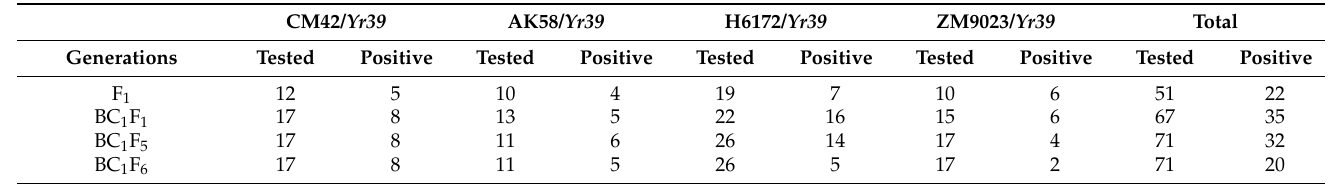
Table 2. Four cultivar (CM42, AK58, H6172 and ZM9023) crosses with Yr39 showed positive lines in different generations as detected by Yr39 -linked RGAP